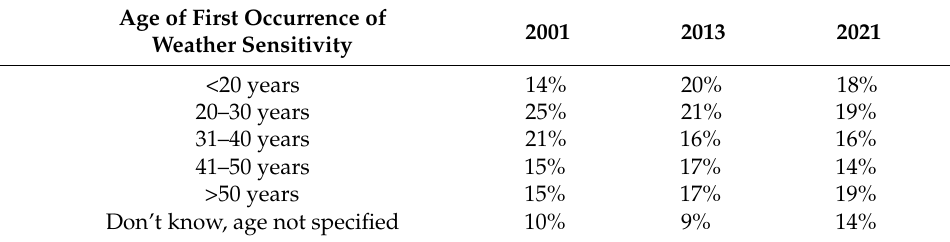
Table 1. The first occurrence of weather sensitivity is about equally frequent at all ages. The data are based on representative surveys by the IfD Allensbach (self-assessment by